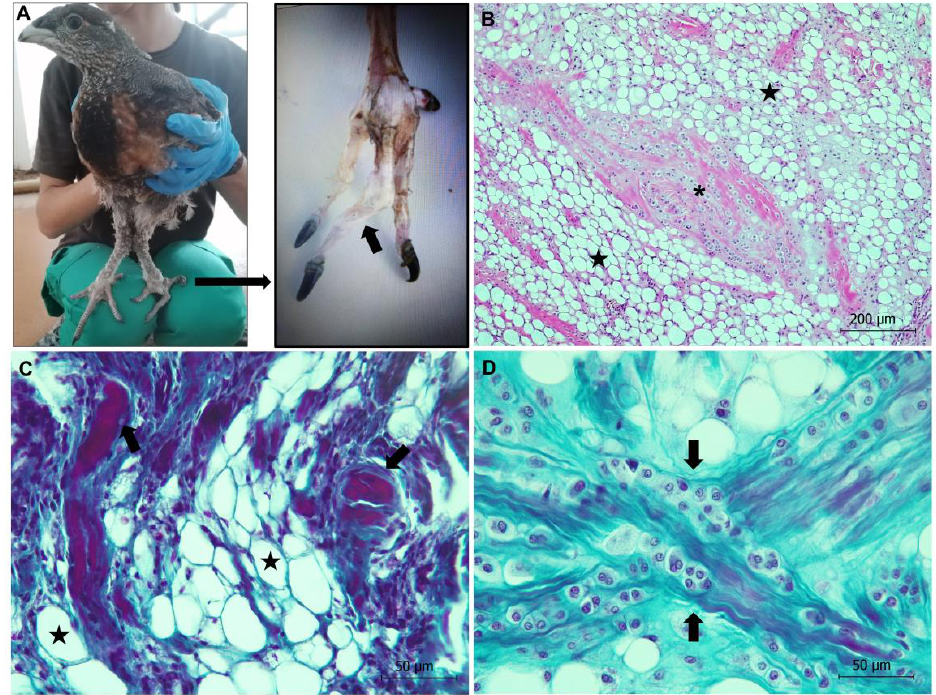
Figure 6. Valgus leg deformity in a Cantabrian capercaillie. ( A ) The left leg is bent outwards at the hock joint (left image). The animal also shows lateral tilting of the distal tibiotarsal condyles (arrow, right image). ( B ) Myotonic dystrophy (stars) and fibrous cartilaginous metaplasia (asterisk) are observed in the region of the tendon and skeletal muscle associated with the femoral head. Hematoxylin-eosin stain. ( C ) Degeneration of muscle fibers that are atrophied (in red, arrows) and replaced by adipose tissue (stars) is observed using Masson ´ s trichrome stain. ( D ) Detail of the fibrous cartilage metaplasia, where chondrocytes are organized forming parallel rows between the collagen bundles (arrows). Masson ´ s trichrome stain.